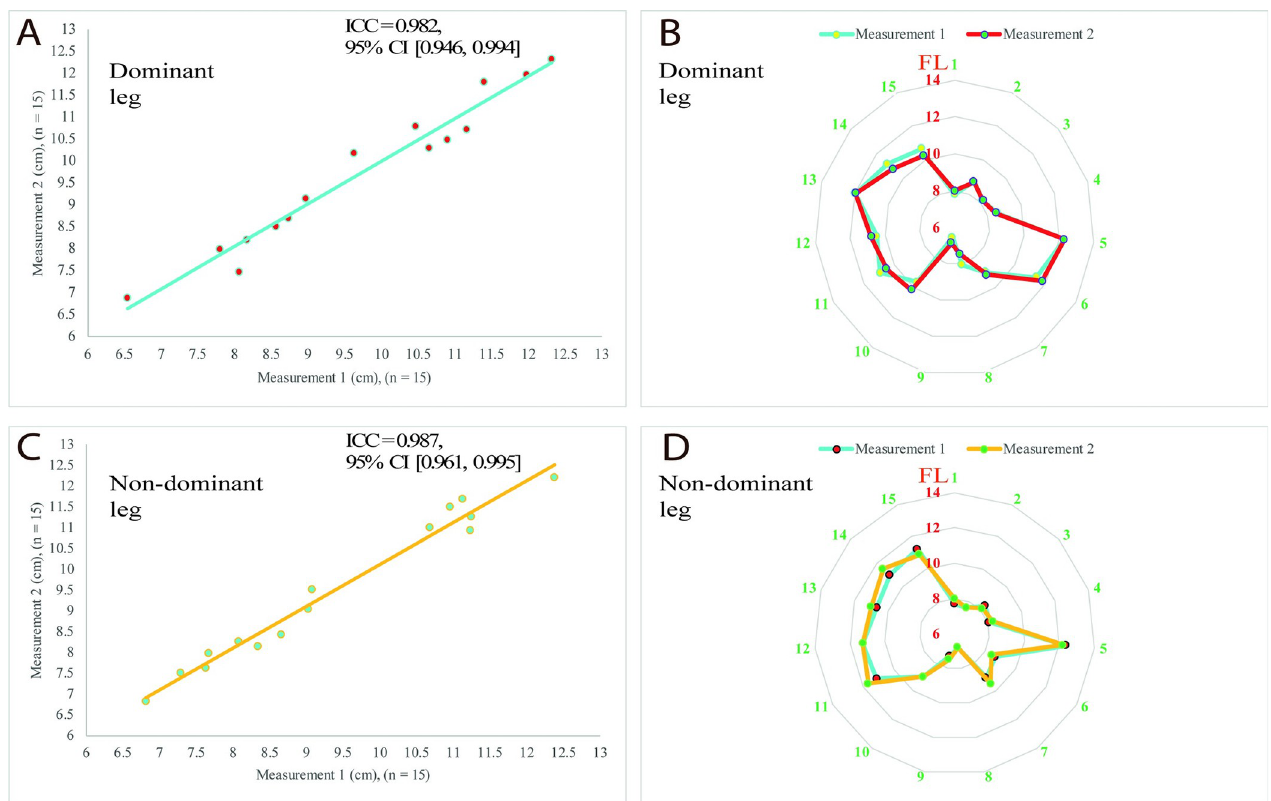
Fig 6. Reliability results of the biceps femoris long head fascicle length measurements for both legs. A: Scatter plots with a regression line for the dominant leg reliability measurements, B: Radar chart for the dominant leg reliability measurements shows agreements between measurements for each participant from 1 to 15, C: Scatter plots with a regression line for the non-dominant leg reliability measurements, D: Radar chart for the non-dominant leg reliability measurements shows agreements between measurements for each participant from 1 to 15. Abbreviations: CI, confidence interval; FL, fascicle length; ICC: Intraclass correlation coefficient; n, sample